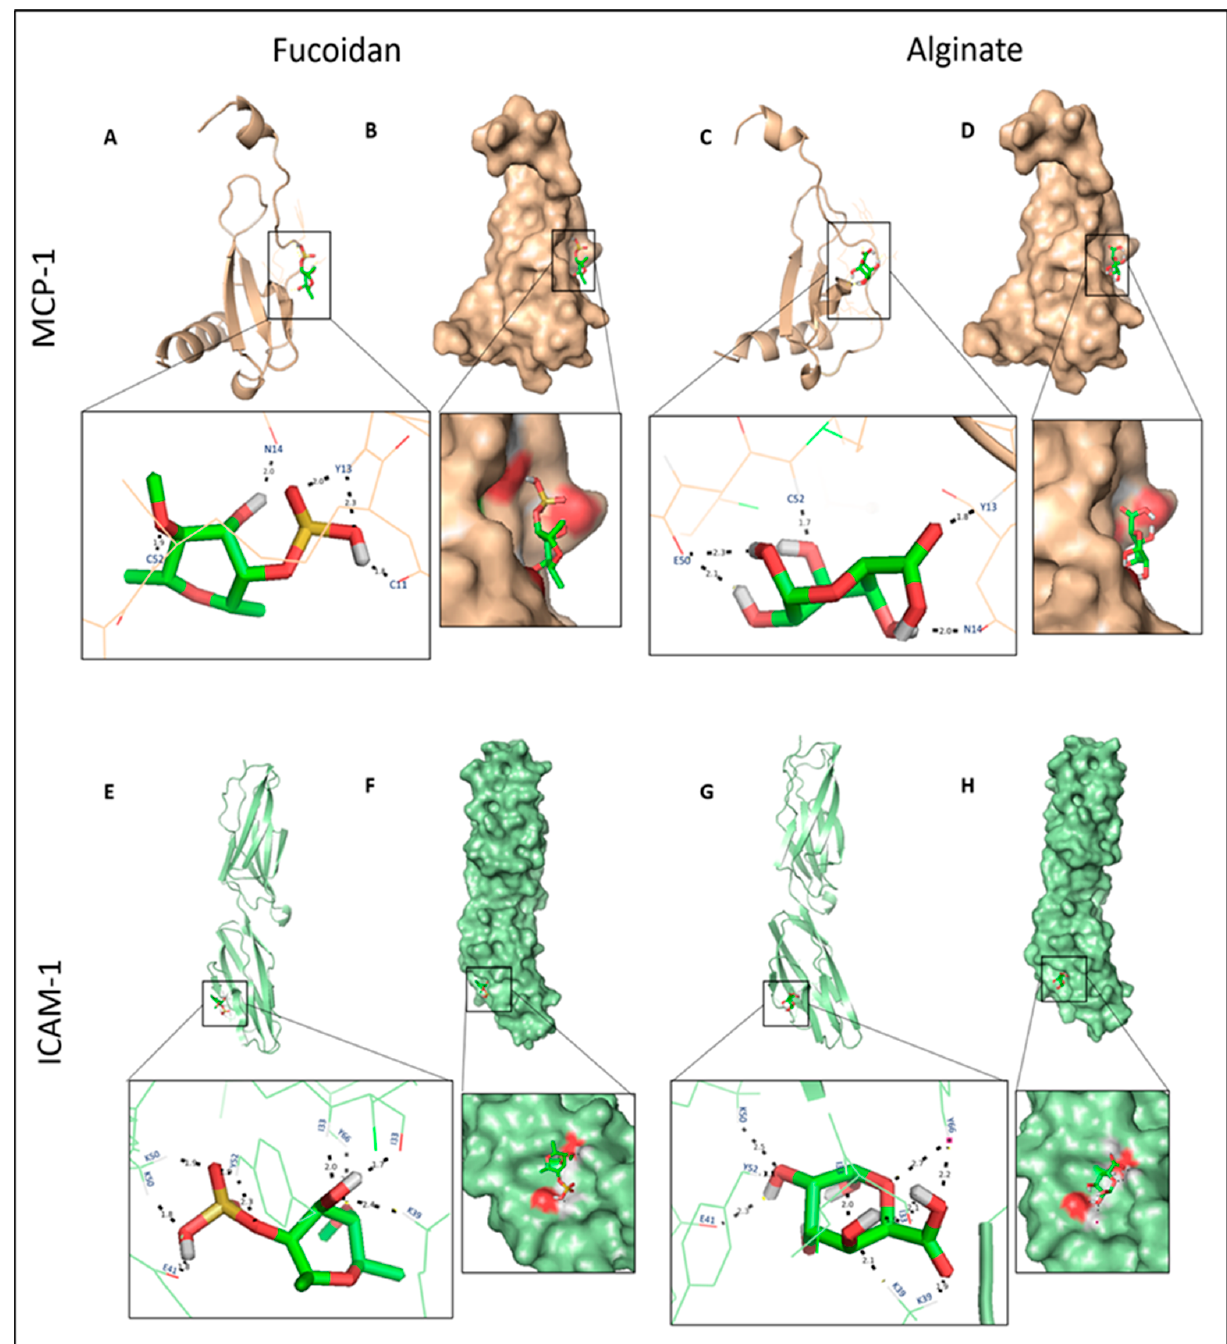
Figure 5. Molecular docking of MCP-1 and ICAM-1 to fucoidan and alginate. ( A , C , E , G ): 3D structures of proteins bound and ligand-binding pocket. Hydrogen bonds is represented by black dotted lines. ( B , D , F , H ): molecular surface representation, and the red patches on the surface represent electrostatic binding pocket. Table 2. AutoDock docking results of marine bioactive compounds (fucoidan and alginate) with inflammatory proteins.